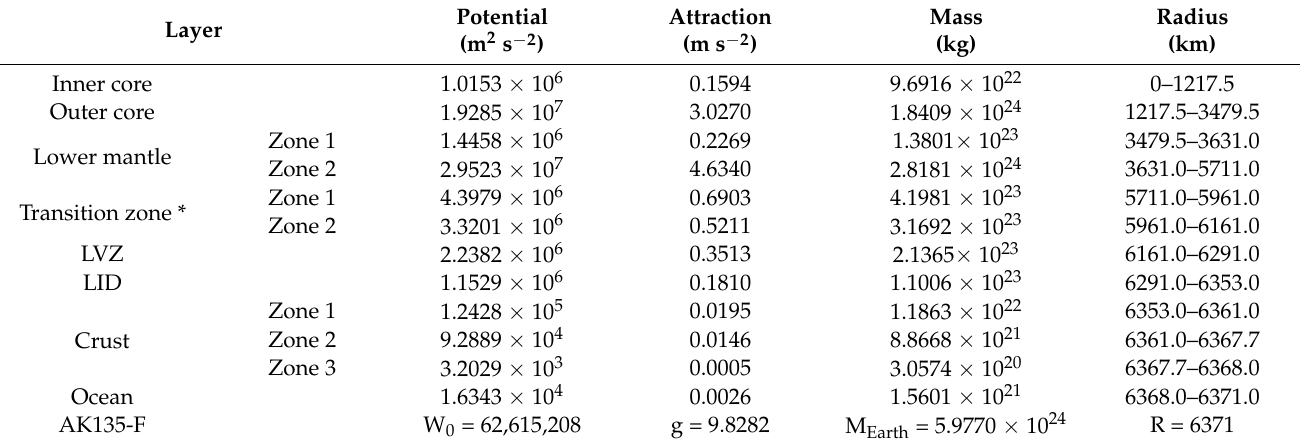
Table 4. Mass, gravitational potential and attraction of the AK135-F model provided in the form of the PREM